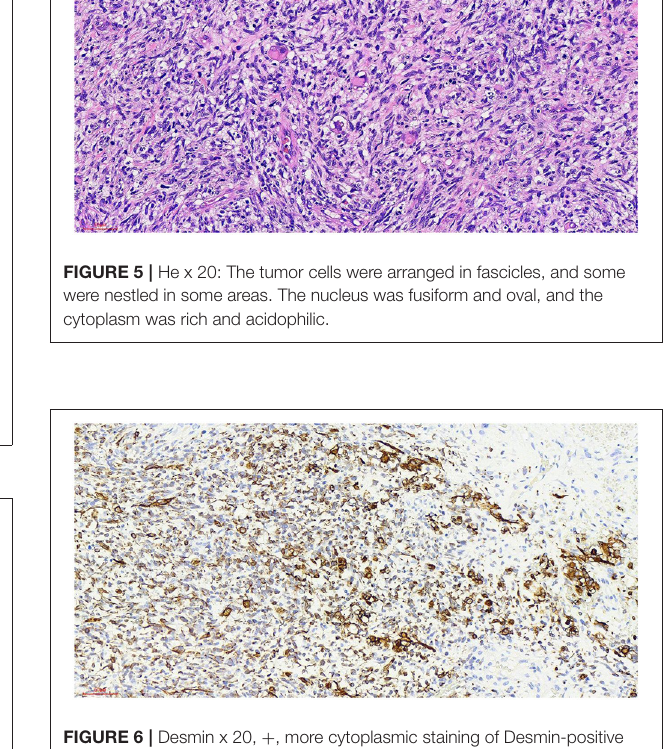
FIGURE 6 | Desmin x 20, + , more cytoplasmic staining of Desmin-positive tumor cells can be seen.